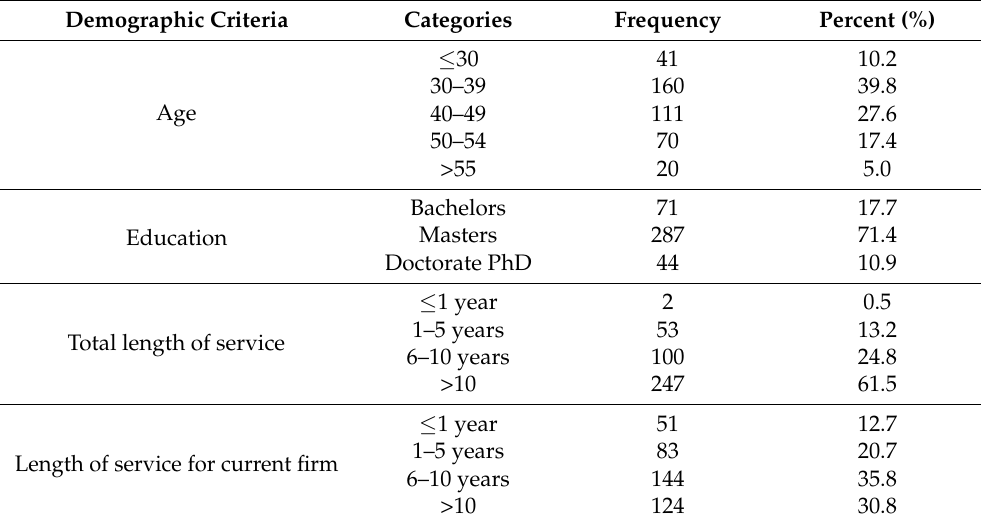
Table 1. Structure of the research sample in the quantitative survey ( n =